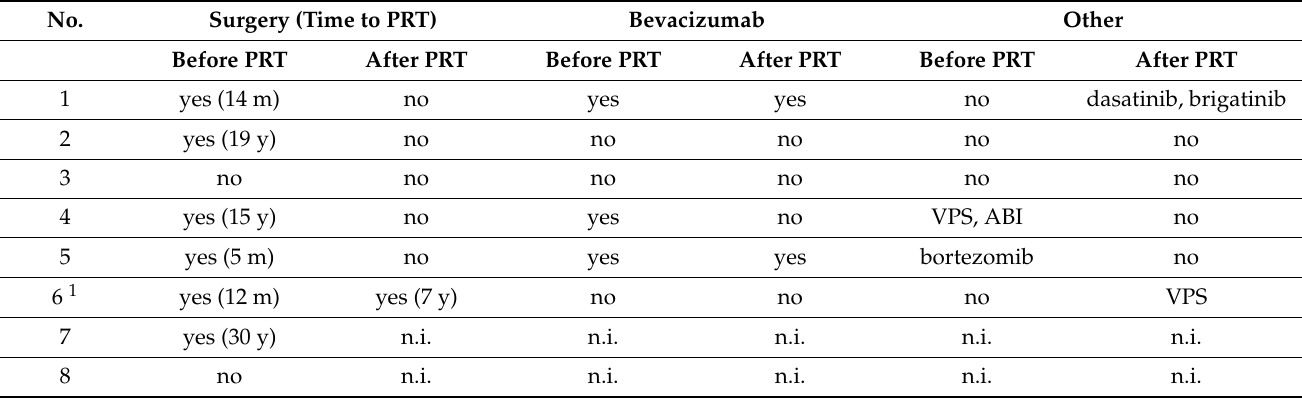
Table 2. An overview of the treatments received in addition to proton